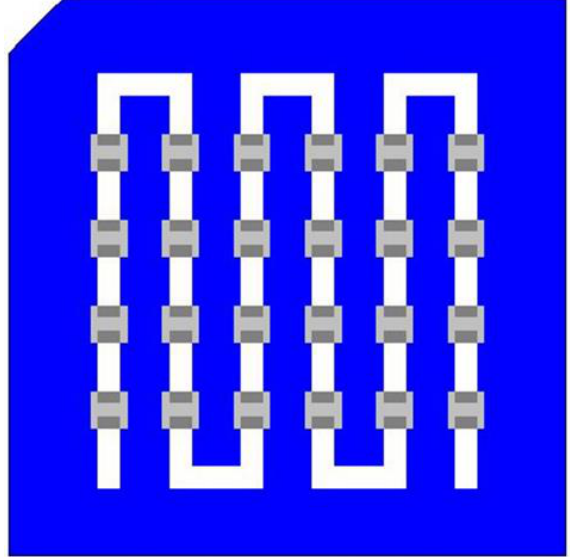
Figure 1. The contact pattern between the Ag and Al electrode. Ag paste was screen-printed into a discontinuous line on the SiN x /Al 2 O 3 passivated Si wafer, and then Al paste was printed into 5 x 5 square pads to interconnect the Ag paste. In order to magnify the contact effect, this model contains 48 Ag/Al joints with an overlap of 4.5 square millimeters for each contact.